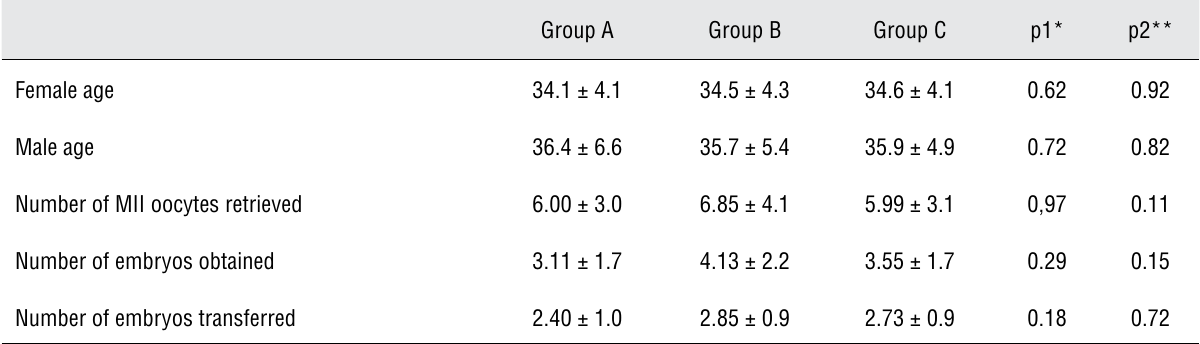
Table 1 - Means of groups and p value for statistical comparison of groups A and B with group C.